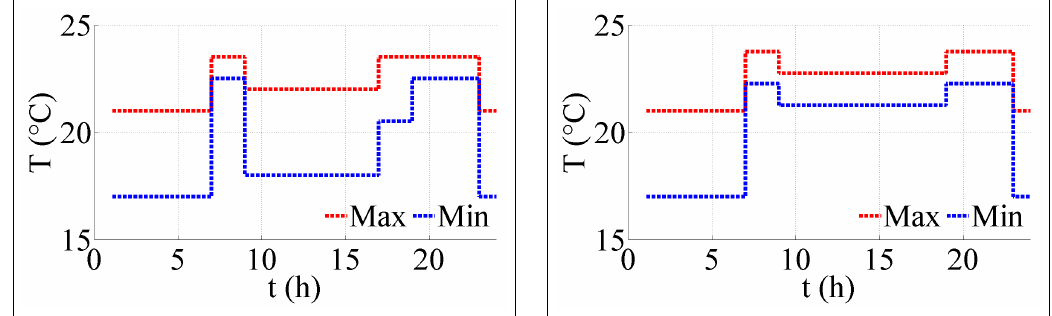
Figure 2. The setpoints for all the 4 rooms related to a weekday and weekend.